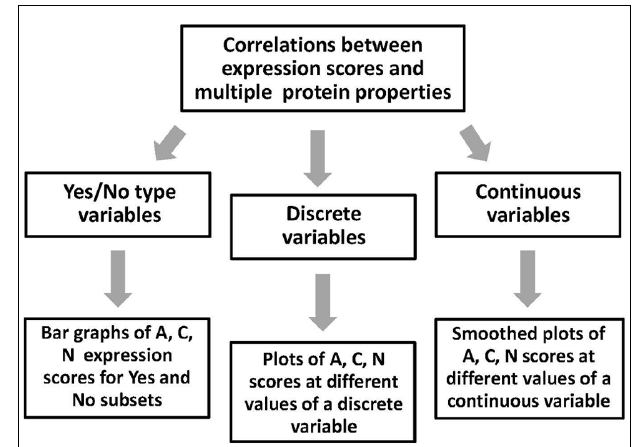
FIGURE 4 | Correlation of expression scores with multiple protein features. Processing and presentation of correlation data depends on the type of analyzed features (variables).The three types of the features processed by this analysis include yes/no, discrete, and continuous